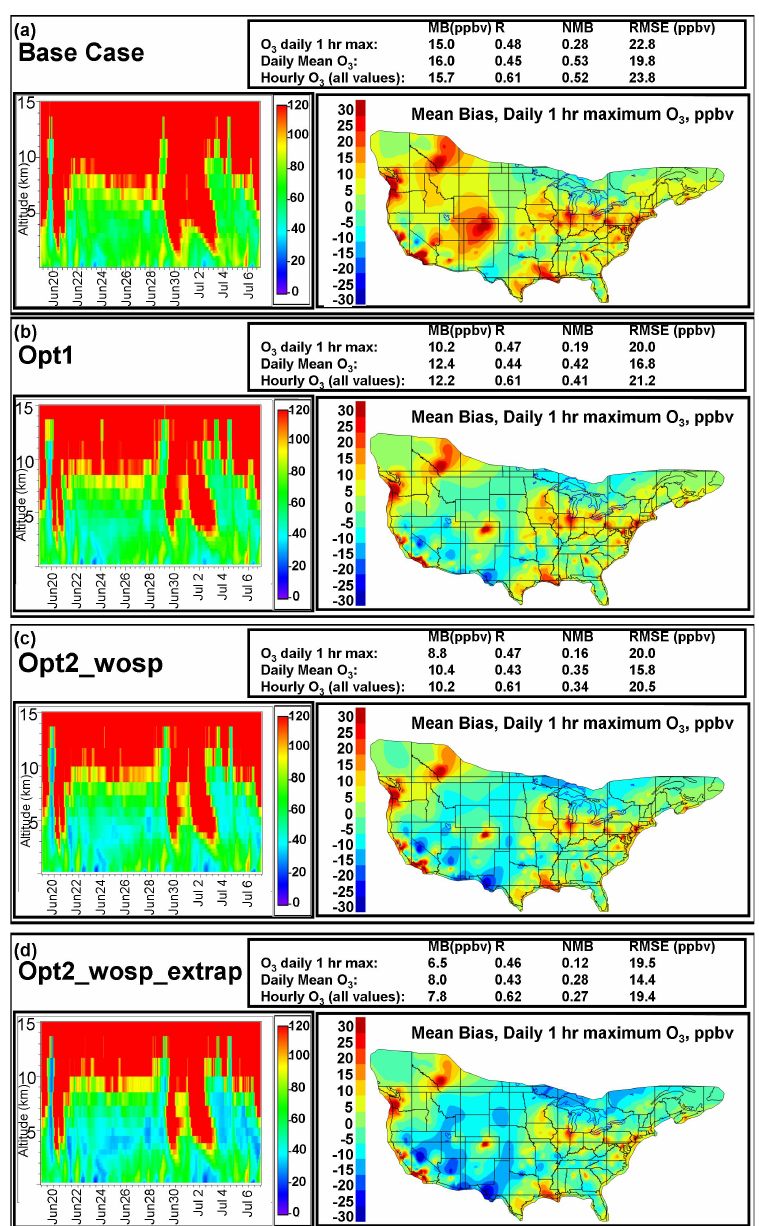
Fig. 5. (a) and (b) : Model-derived ozone profiles for comparison to ozonesondes(left), 42km domain statistics (upper right), and kriged mean bias of surface maximum daily ozone (lower right), for Base Case and Opt1 methodologies, 3 June–31 August 2007. (c) and (d) : As in (a) and (b), but for Opt2 wosp and Opt2 wosp extrap